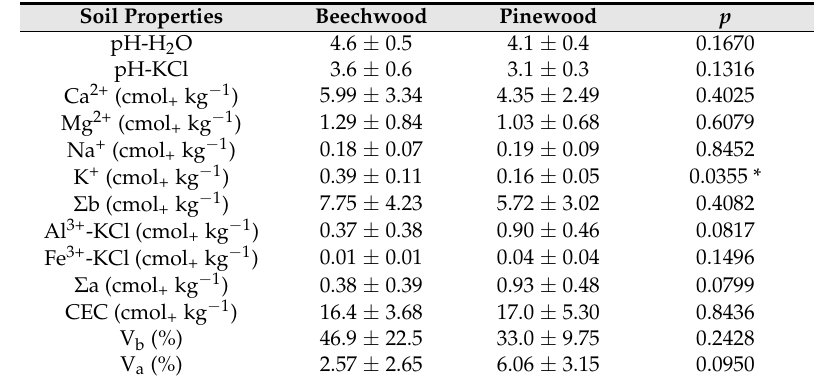
Table 1. Topsoil chemical properties of Ah horizons (0–10 cm). Total organic C (TOC), total N, soil C/N ratio, exchangeable basic cations (Ca 2+ , Mg 2+ , Na + , K + ), exchangeable acid cations (Fe 3+ , Al 3+ ), sum of basic ( Σ b) and acid ( Σ a) cations, cation exchange capacity (CEC), bases (V b ), and acid (V a ) saturation. Values are expressed as mean ± standard deviation ( n = 5). p indicates the p -value obtained from the one-way ANOVA test and significant differences ( p < 0.05) are marked with